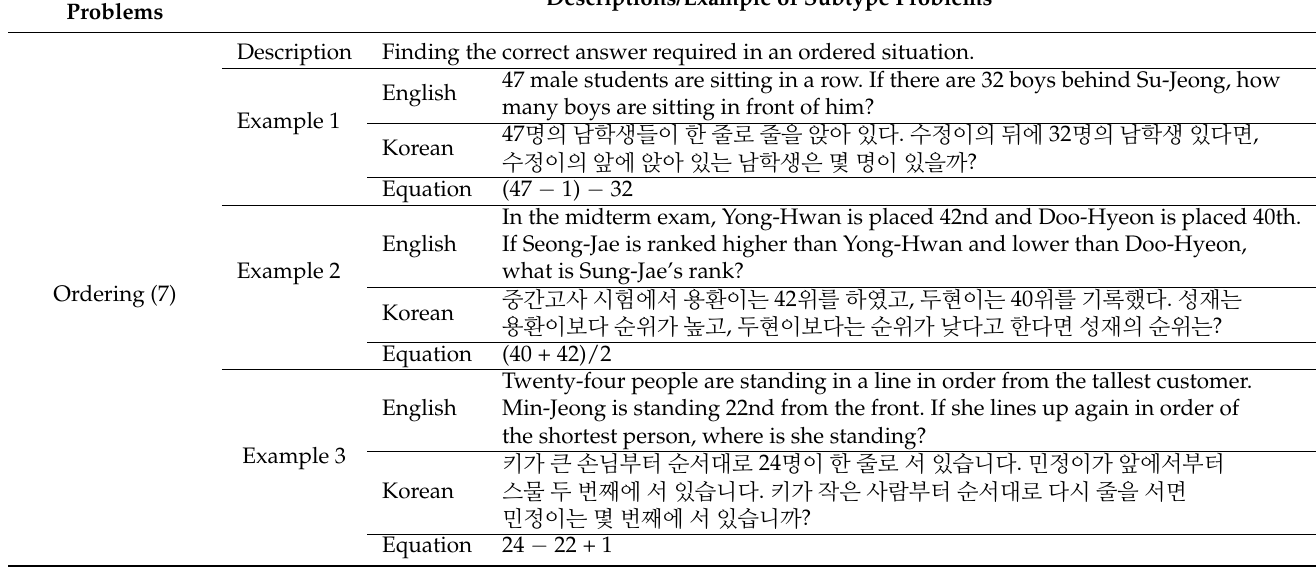
Table 2. Examples of the ordering type.